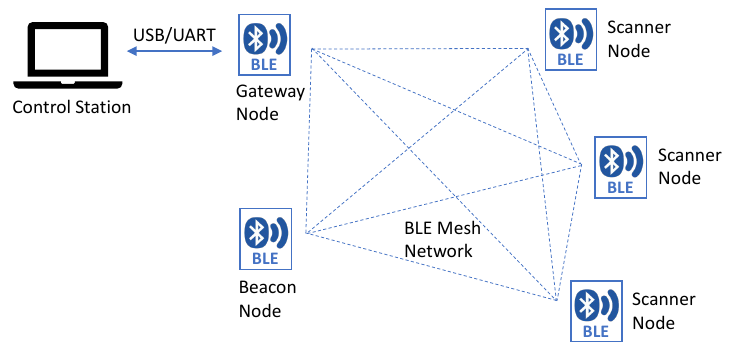
Figure 3. System architecture of the measurement mesh